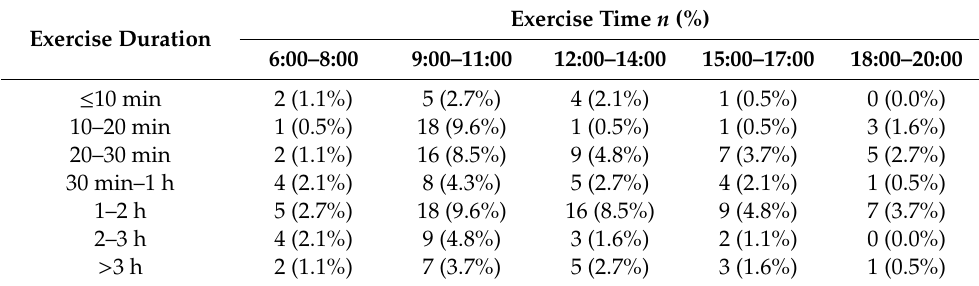
Table 4. Exercise time of the participants in di ff erent exercise duration groups in the green spaces. Exercise